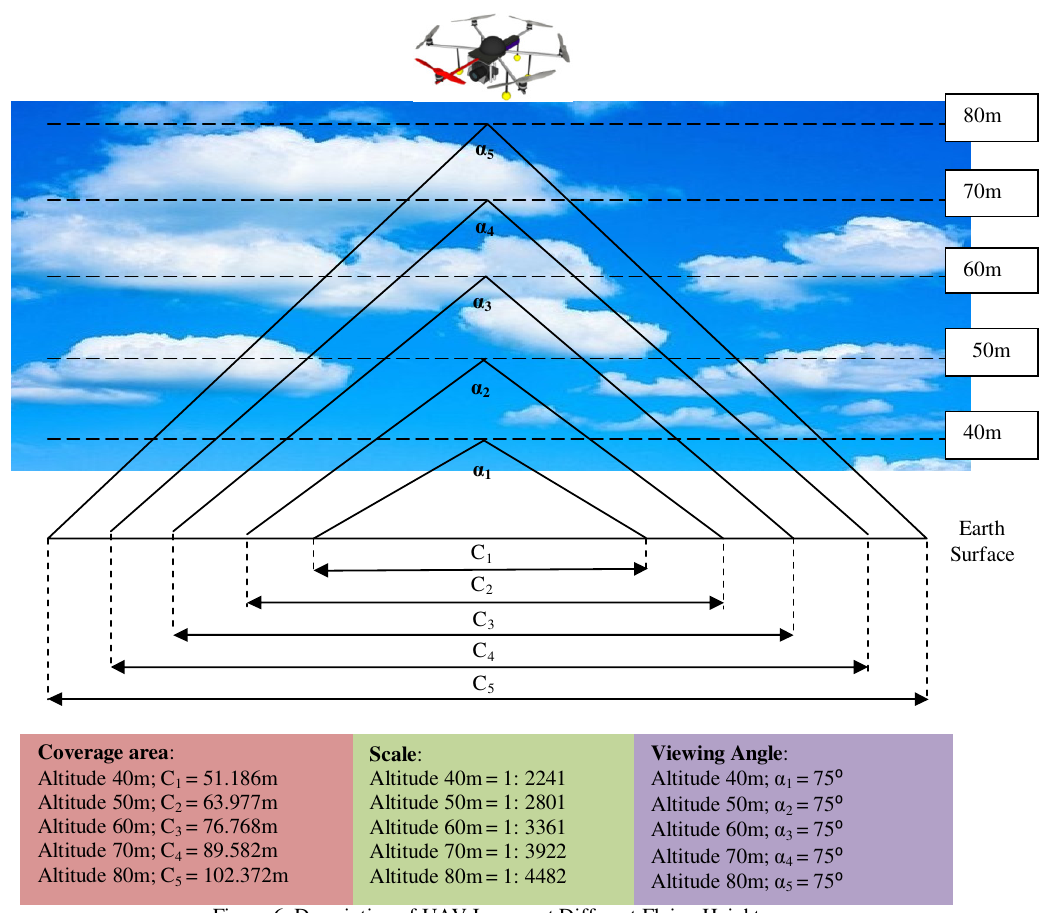
Figure 6. Description of UAV Images at Different Flying Height Based on Table 4, the maximum RMSE value for ground control points X coordinate is +1.116m (50m) and the minimum RMSE value is +0.488m (80m). The maximum value for ground control points Y coordinates is +0.779m (50m) and the minimum RMSE value is +0.306m (70m). The maximum value for ground control points Z coordinates is +2.029 (50m) and the minimum RMSE value is +0.170m (80m). The maximum RMSE value for ground control points XY coordinates is +1.361m (50m) and the minimum RMSE value for XY coordinates is +0.679m (70m). The tabular data for ground control points are represented in the graph shown in Figure 7. Figure 7. Graph of RMSE for Ground Control Points (Different Table 4. RMSE Results for the Different Altitude Altitude) Referring to Figure 7, the graph of RMSE for ground control points produced from UAV images are captured at different altitudes. This graph shows the RMSE results for X and Y coordinates are not significant, but Z coordinates display a huge range for different flying height. However, the difference between X and Y coordinates is about + 0.6 metres while Z coordinate is about +1.7 metres. The maximum RMSE value for checkpoints X coordinate is +0.738m (50m) and the minimum RMSE value is +0.311m (70m). The maximum RMSE value for checkpoints Y coordinate is +1.105m (50m) and the minimum RMSE value is +0.450m